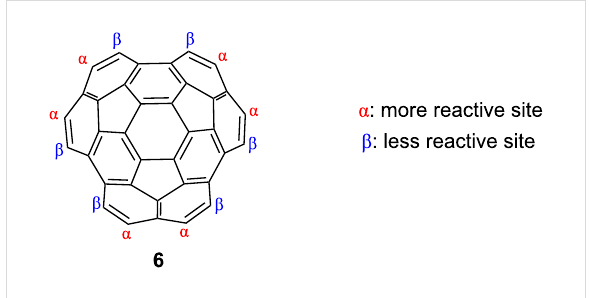
Figure 9: Two different types of rim carbon atoms on